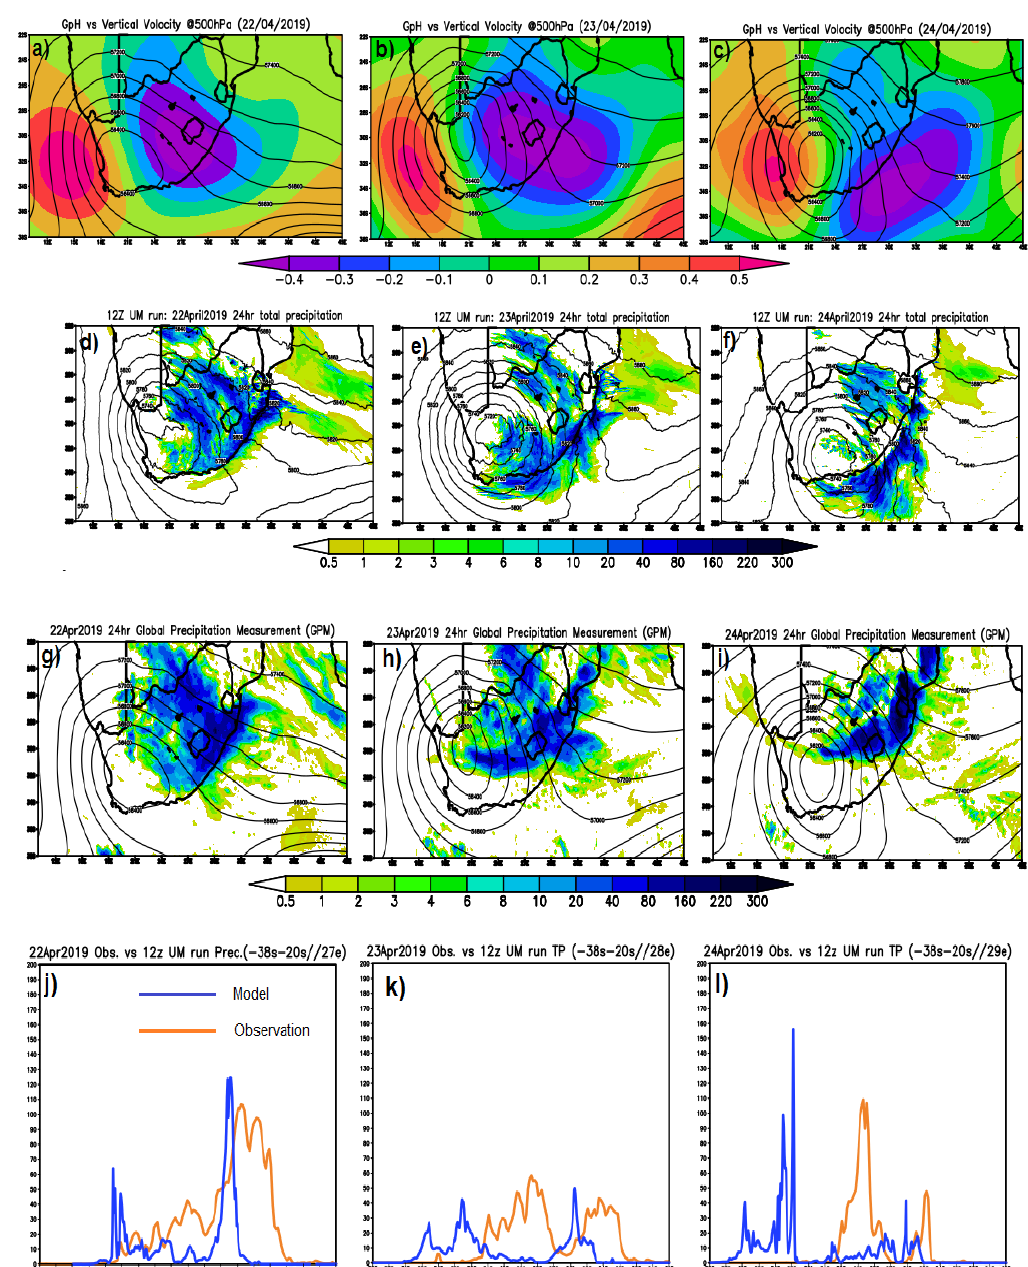
Figure 10. Geopotential height at 500 hPa (thin black contours) together vertical velocity (shaded) ( a , b , c ), at 12Z UM 24 h on the 22nd, 23rd and 24th April 2019. The second-row panels ( d , e , f ) show UM total precipitation (shaded) and geopotential height at 500 hPa, at the same as time as in the top panels. The third-row panels ( g , h , i ) show the total Precipitation and geopotential Height at 500 hPa for the ERA Interim for the same time as in ( a , b , c ). The bottom panels ( j,k,l ) show model (blue curve) and observation (orange curve) diurnal cycle precipitation for the same times as in ( a , b , c ).